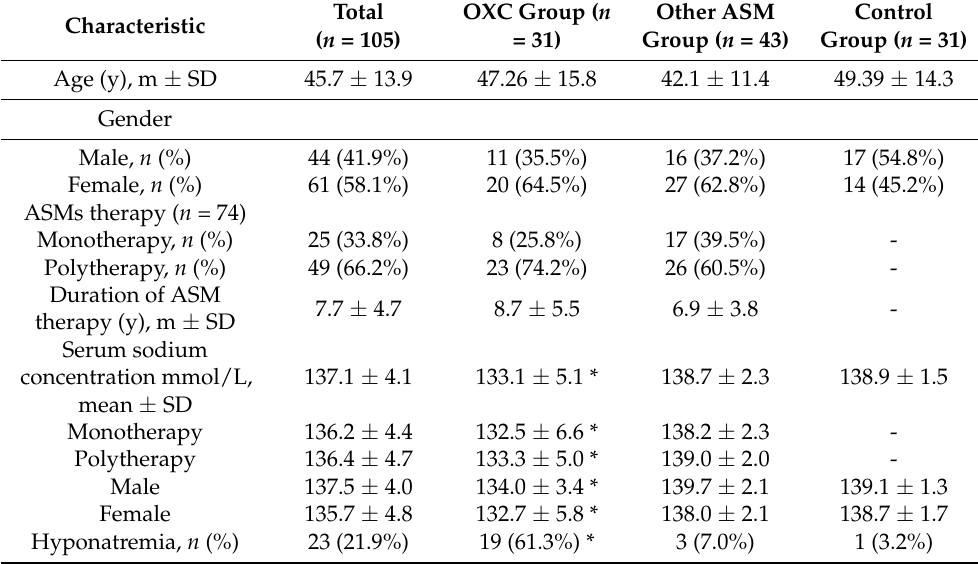
Table 1. Clinical and demographic